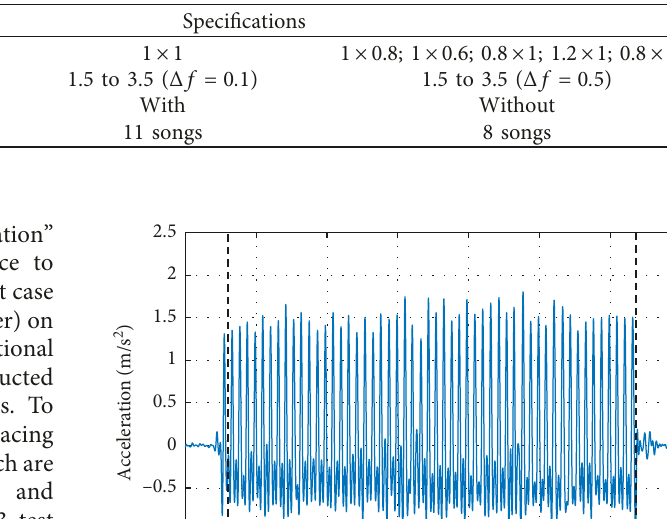
Table 3: Specification of the performed tests.